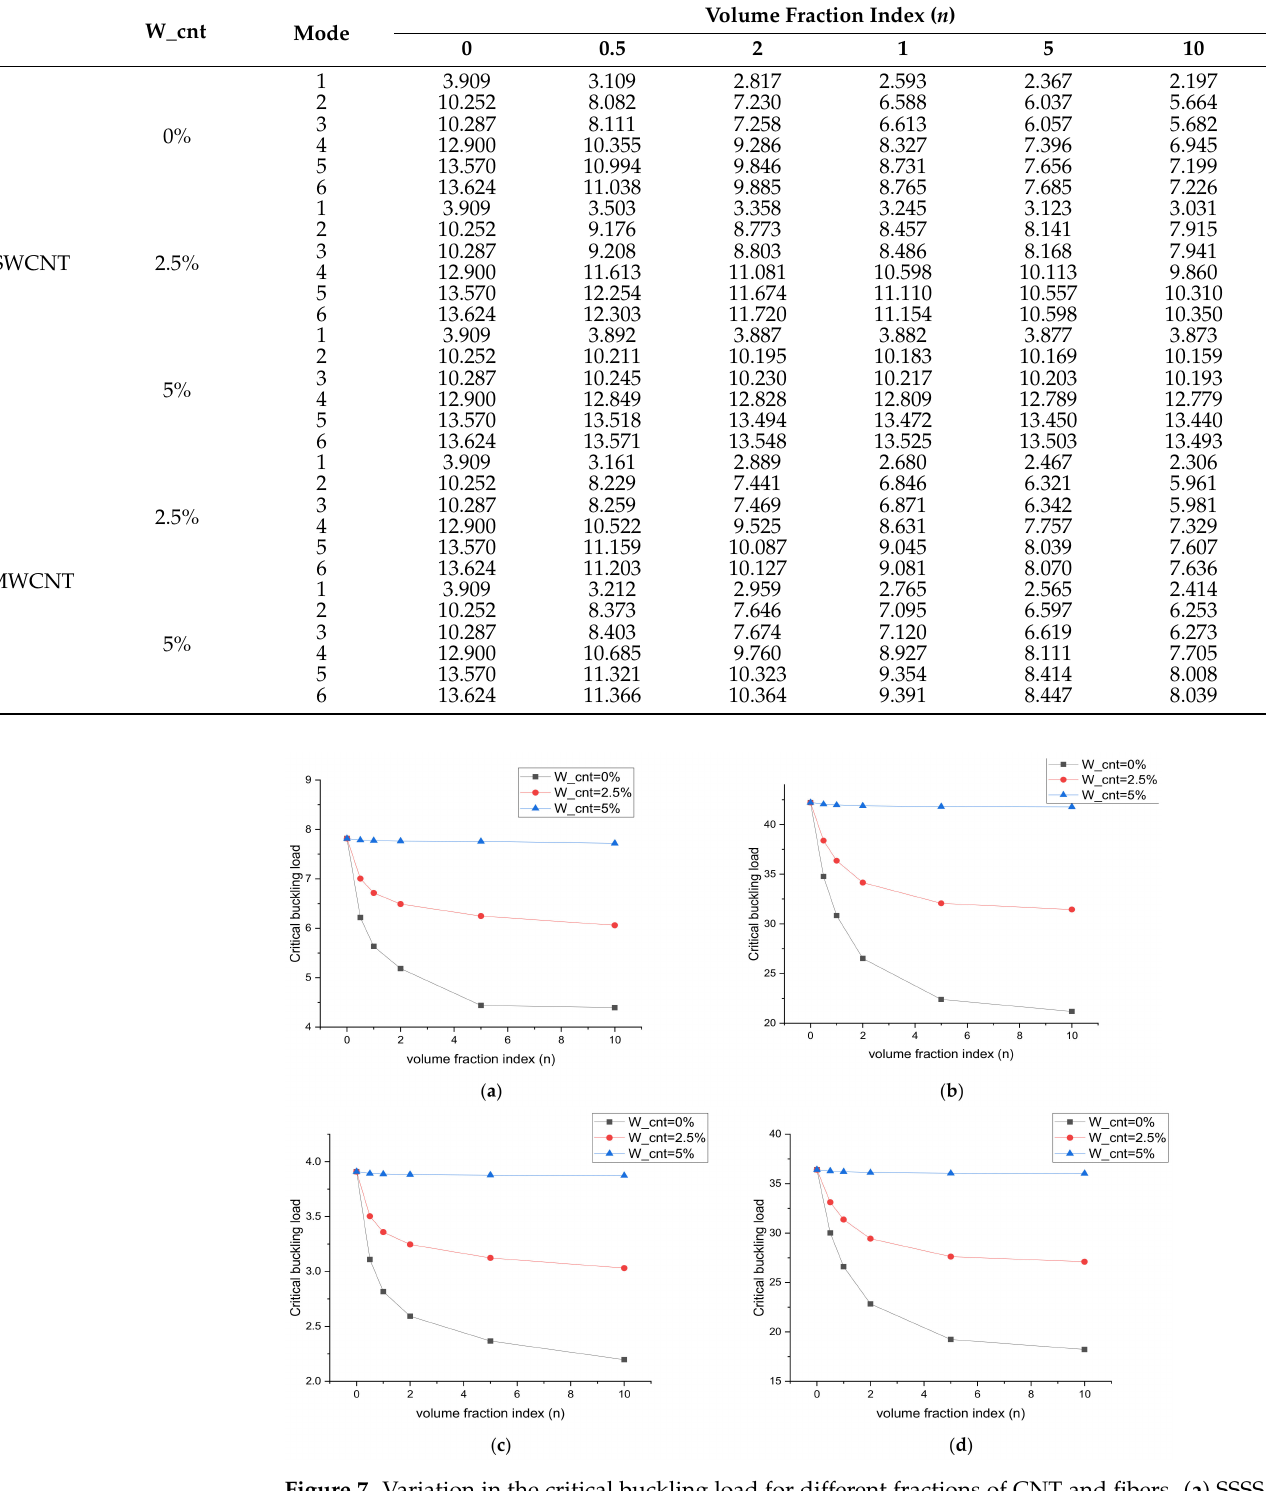
Table 6. Critical buckling load for the 1st six modes (Al/ZrO 2 ) under biaxial load.